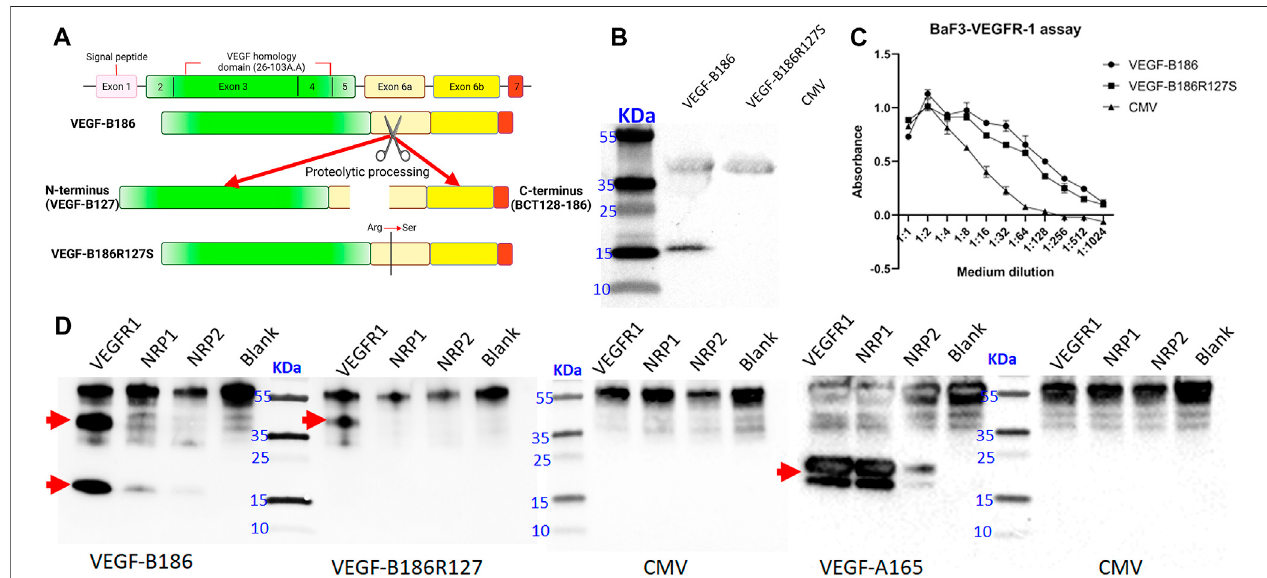
FIGURE 1 | Characterization of the designed proteolytically resistant VEGF-B186R127S. (A) Graphical representation of VEGF-B186R127S. (B) Representative image of VEGF-B protein expression following HeLa cell transduction. (C) BaF3-VEGFR1 cell survival and proliferation assay. Each dot represents mean ± SD from two technical replicates from a representative experiment . (D) Receptor binding properties of different VEGF-B forms. Each lane represents the precipitation of ligands with hVEGFR1, hNRP1, hNRP2, or no receptor (blank). Red arrow signs indicate the full-length and proteolytically processed VEGF-B186, VEGF-B186R127S, or